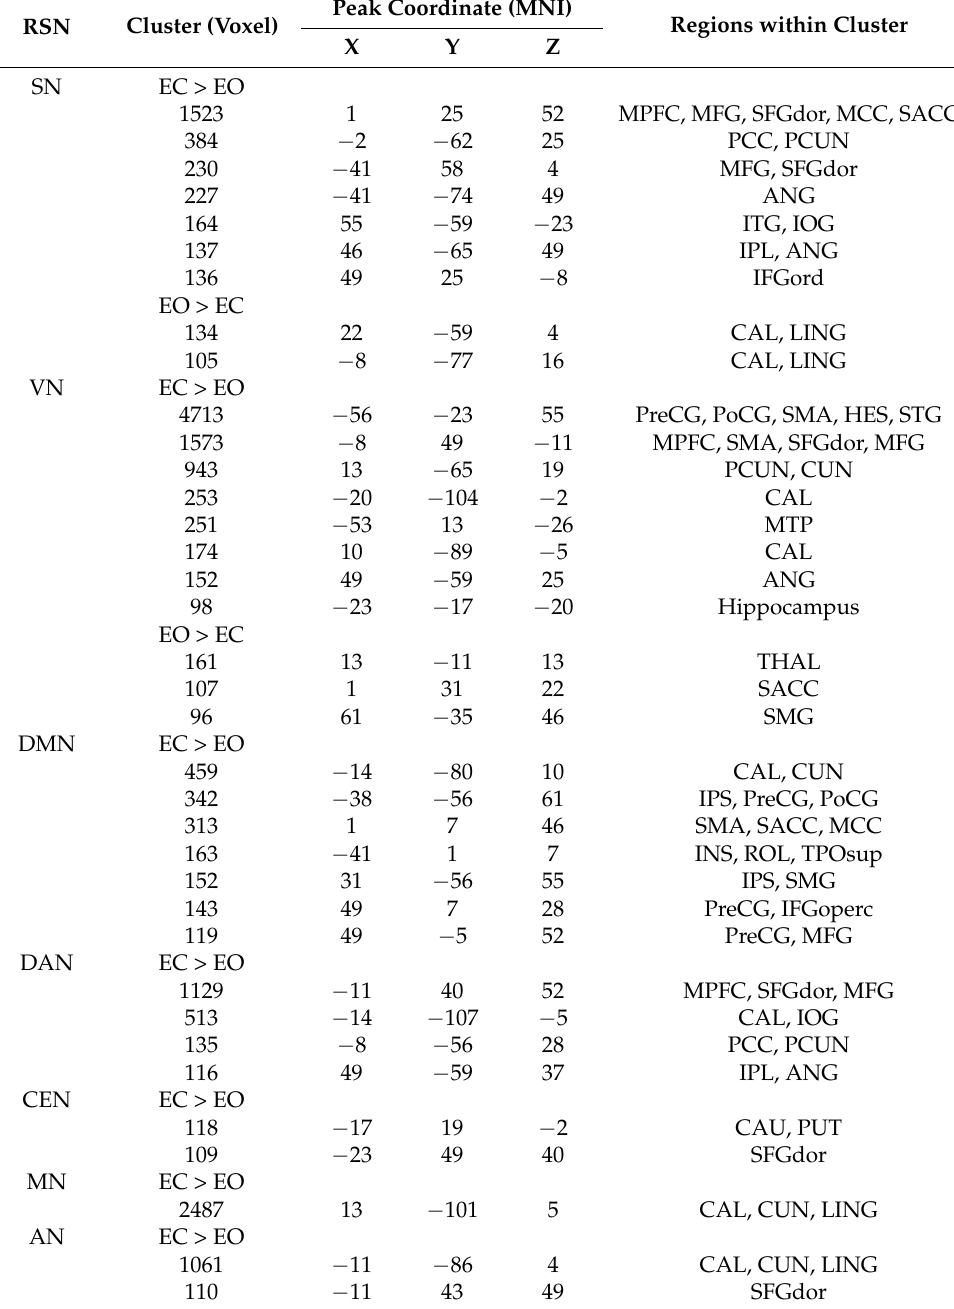
Table 2. Regional details of FC difference for each